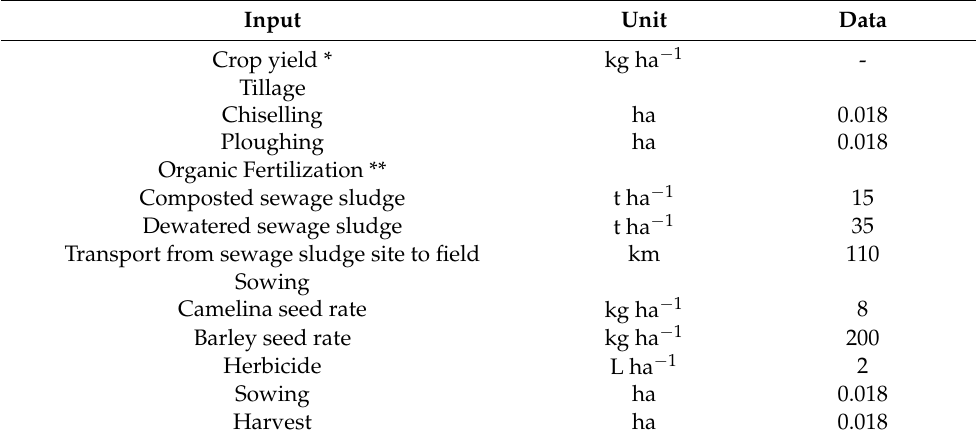
Table A1. Data inventory for crop rotation camelina-barley-camelina with organic fertilizations (composted sludge and dewatered sludge).